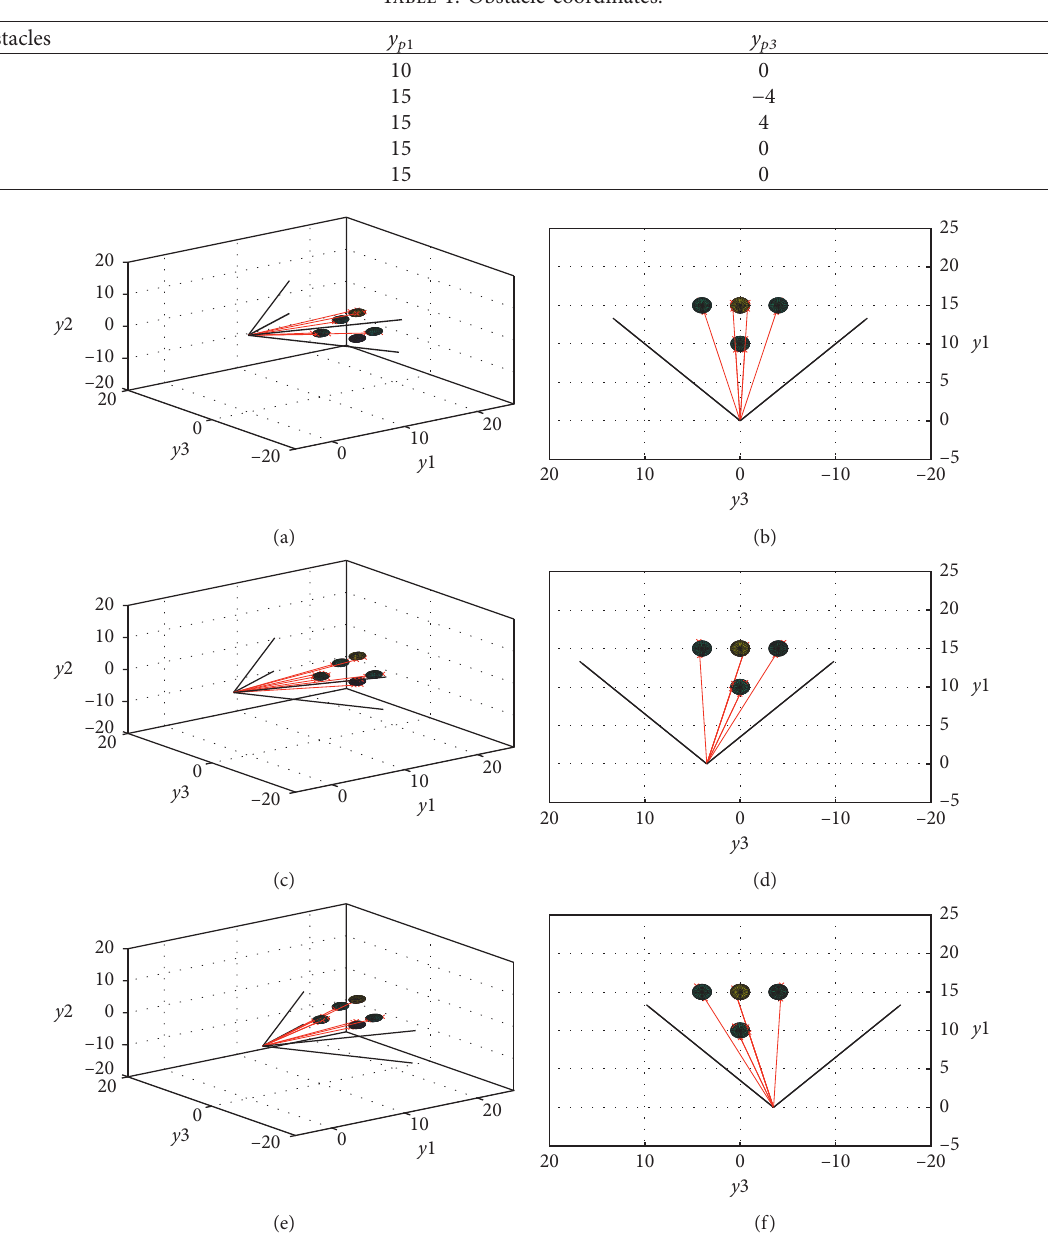
Figure 30: Simulating the work of CVS: ( a ) 3D view of AMR no. 1; (b) plan view of AMR no. 1; (c) 3D view of AMR no. 2; (d) plan view of AMR no. 2; (e) 3D view of AMR no. 3; (f) plan view of AMR no.